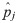
Top panel: Estimated σ and ρ as a function of p^j for 37 areas in Minetti et. al [27], with loess smooth overlayed.Bottom panel: Solid line represents OC curve for n = 60, d = 50 for p
l = .75, p
u = .9 design when σ and ρ are fixed at the mean value of σ^ (left) and ρ^ (right). Dashed line represents OC curve when σ and ρ vary over p according to the predicted loess smooth of σ^ (left) and ρ^ (right).